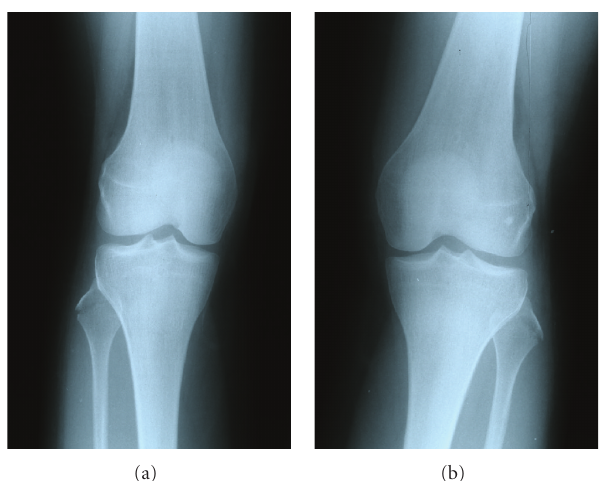
Figure 1: Anteroposterior radiographs of both knees immediately after trauma. Fractures of the lateral borders of both fibular heads are easily seen.